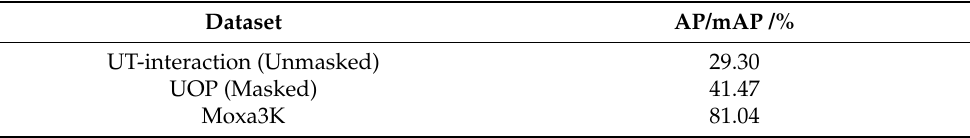
Table 3. Performance metrics of the mask detection.